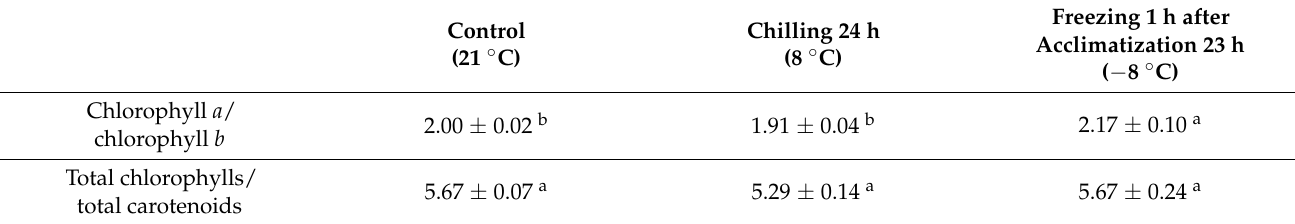
Table 1. The ratio of chlorophyll a/chlorophyll b and total chlorophylls/total carotenoids in kale exposed to low tempera- tures. Value marked with different letters are significantly different at p < 0.05.